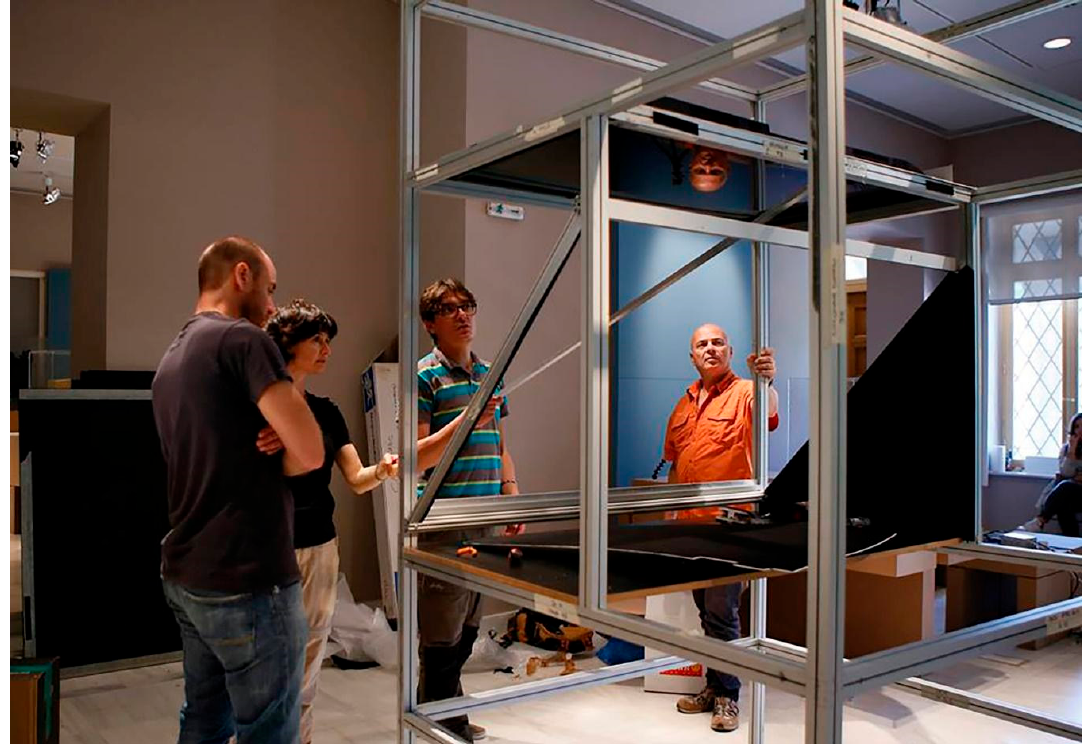
Figure 10. Structure of the showcase in aluminum profiles, a step of the setup.